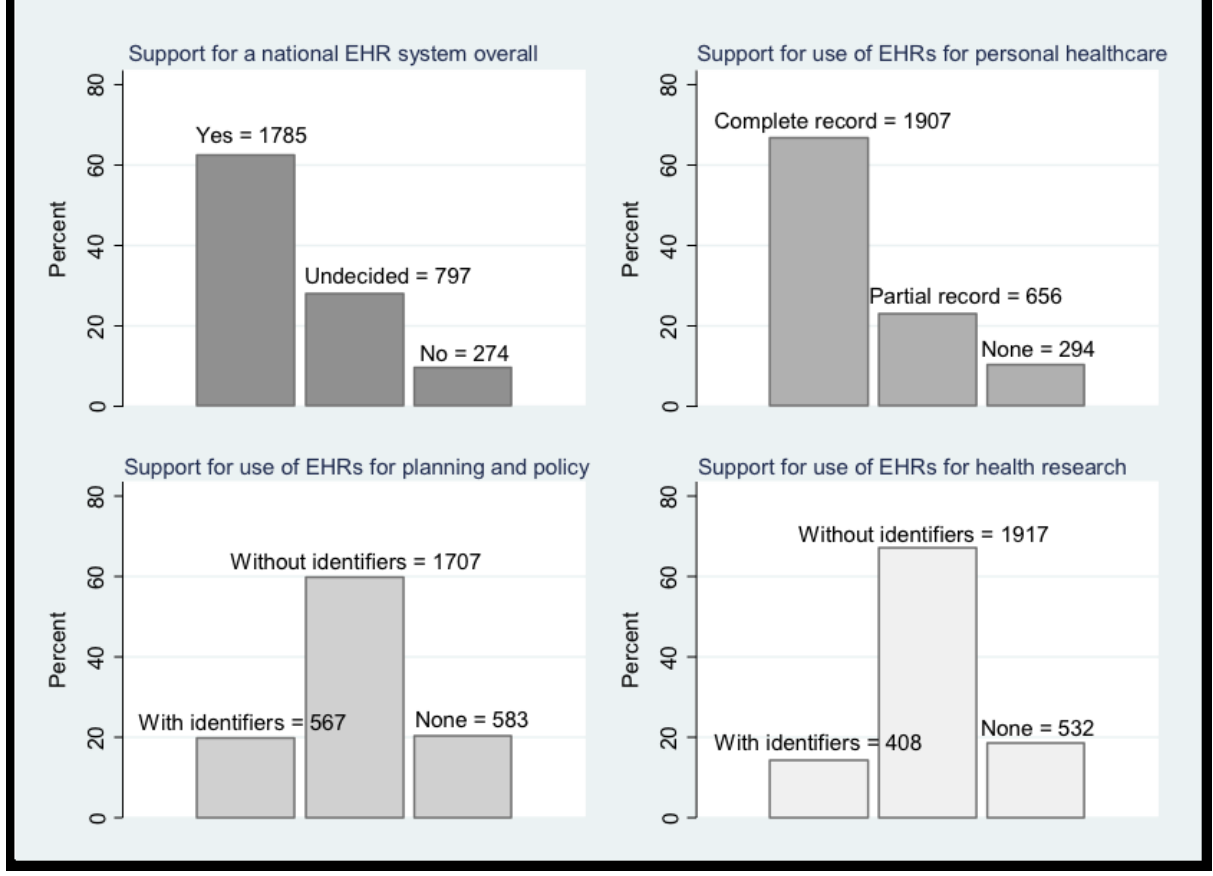
Figure 1. Respondents’ overall preferences for the development of a national electronic health records system and their views on the use of complete or partial records for health care purposes, and identifiable or anonymized records for health services planning and policy, and health research